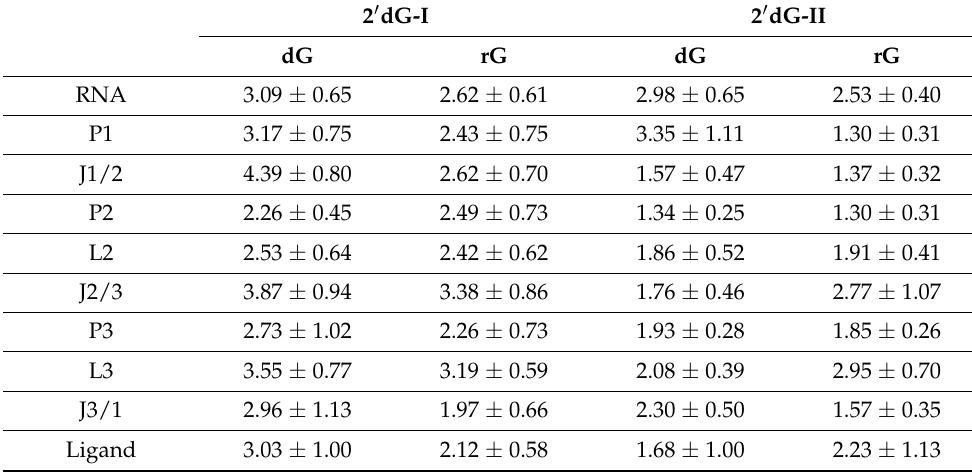
Table 1. Root-mean-square deviations of 2 (cid:48) dG riboswitches as a whole and for substructures bound with dG and rG a .